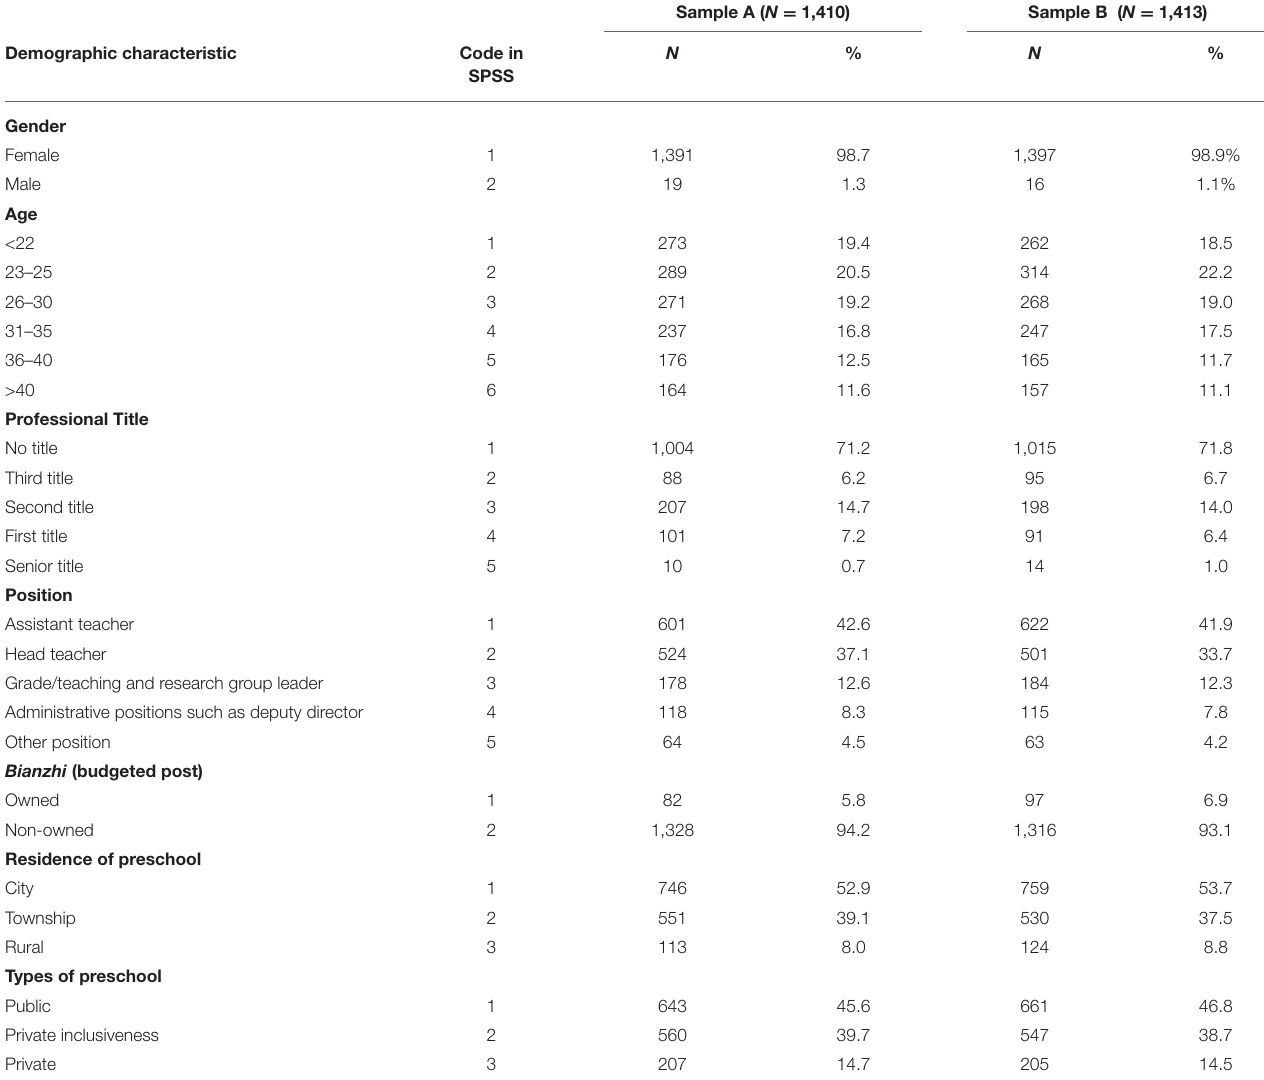
TABLE 1 | Demographics of participants ( N =